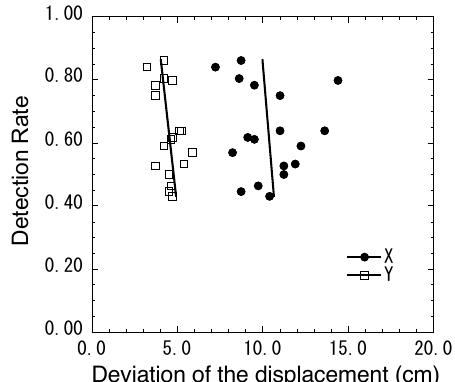
Figure 7. Relationships between the detection rate and the deviation of the displacement. Each plot shows the spatial deviation of the displacement for each slave image